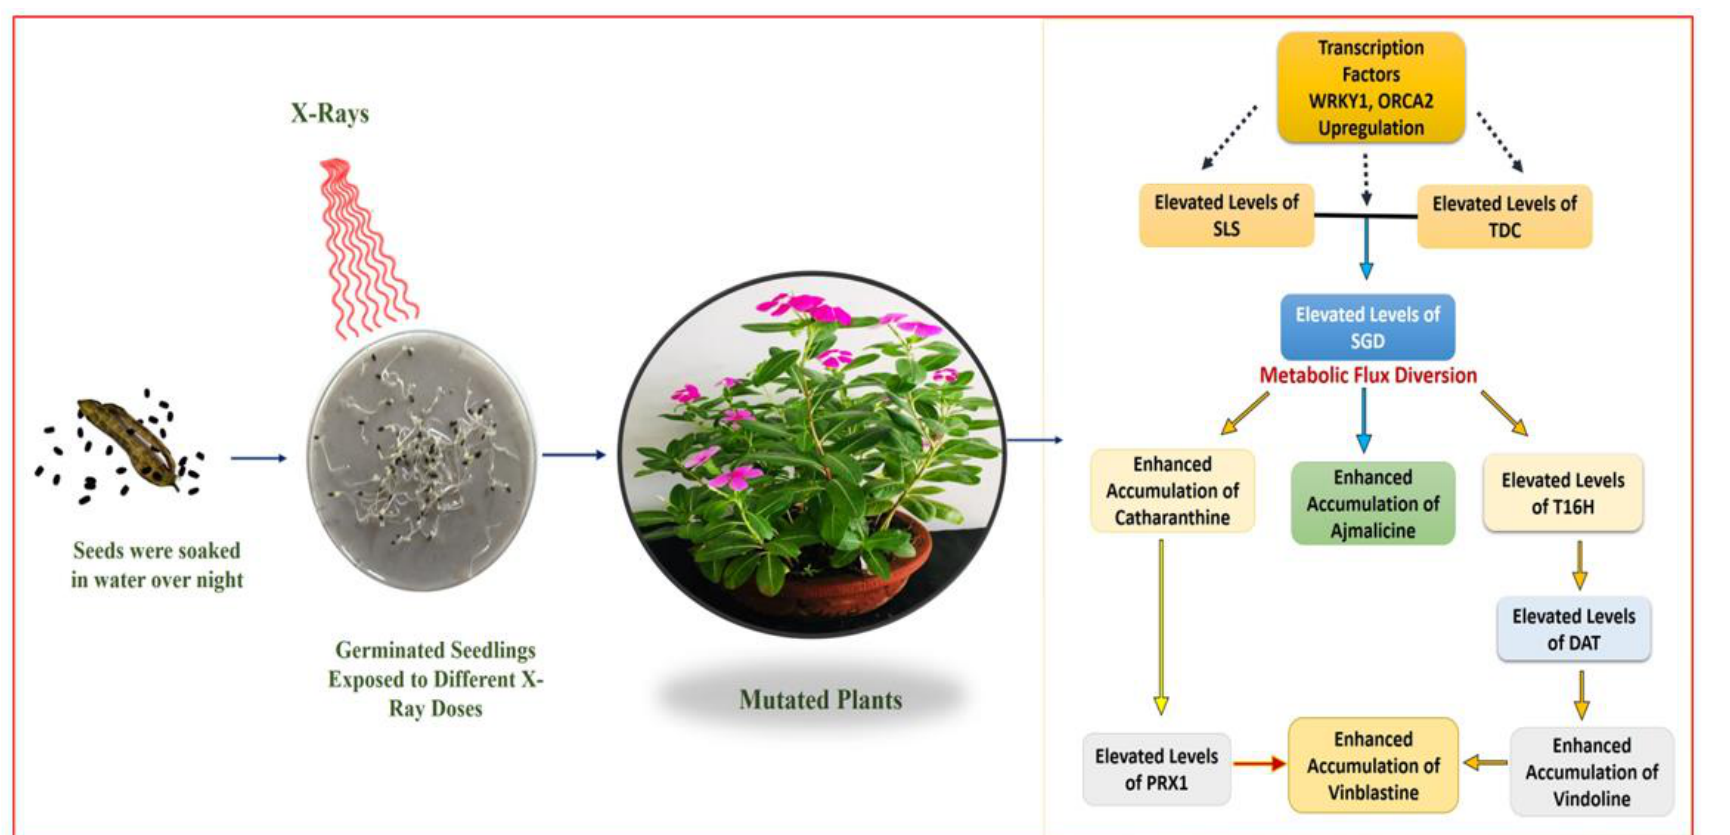
Figure 10. Mutagenesis ’ possible correlation with MIA content and gene expression in X-ray-mutated plants.